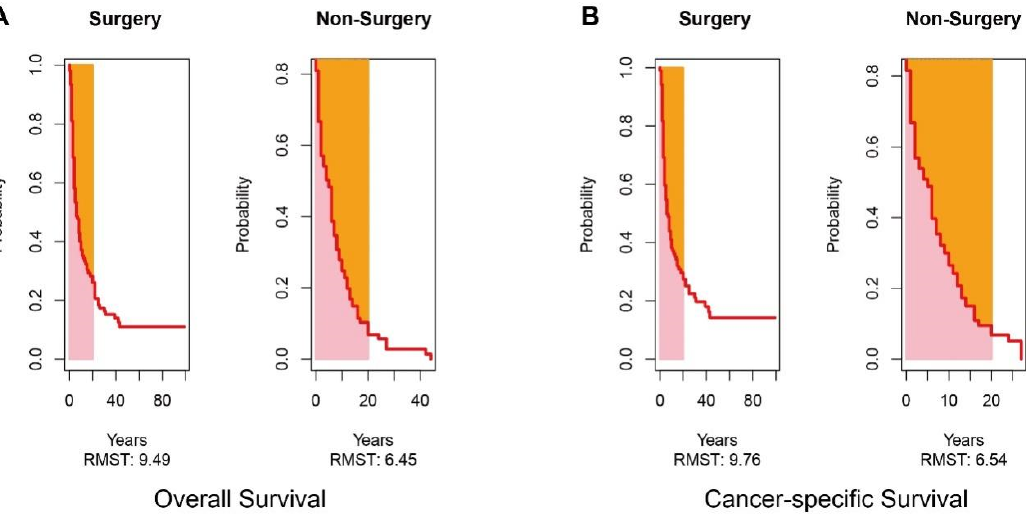
Figure 5. Analysis of restricted mean survival time (RMST). RMST analysis of overall survival ( A ) and cancer-specific survival ( B ) in two groups. Table 2. RMST and RMTL analysis for mPDAC